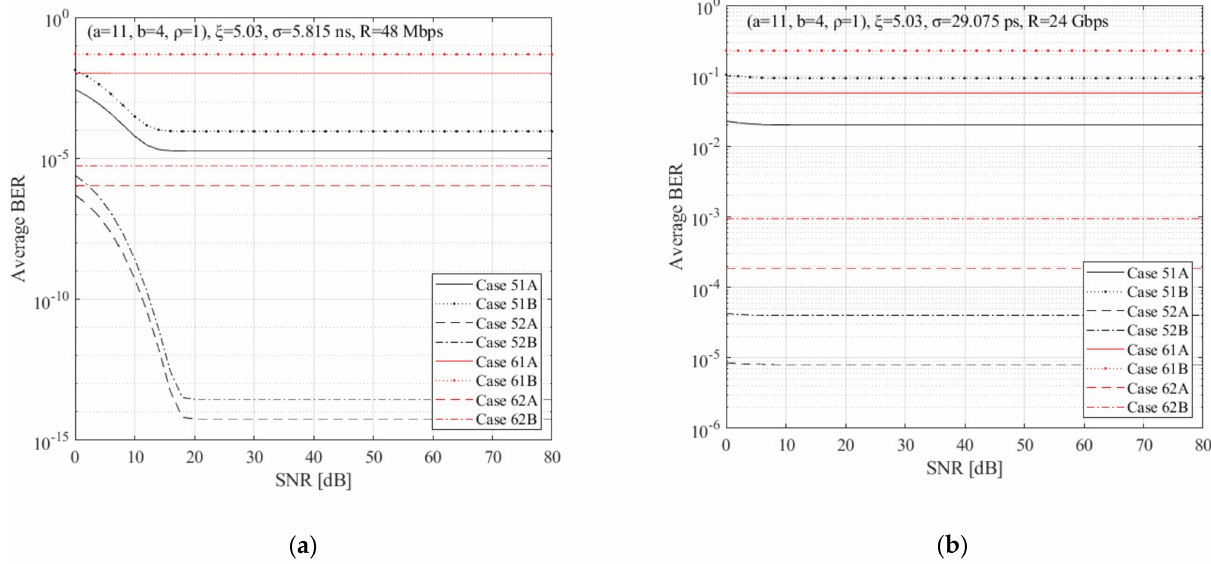
Figure 6. ABER versus expected SNR for ( a = 11, b = 4, ρ = 1), ξ = 5.03, L -PPM schemes, and various diversity and DF multi-hop parameters, with ( a ) R = 48 Mbps, σ = 5.815 × 10 − 9 s ( α = 10 − 8 s, β = 4) and ( b ) R = 24 Gbps, σ = 29.075 × 10 − 12 s ( α = 5 × 10 − 11 s, β = 4). The studied curve cases are codified as follows: Case 51A: 4-PPM, N = 3 , M = 1; Case 51B: 4-PPM , N = 3 , M = 5; Case 52A: 4-PPM , N = 9 , M = 1; Case 52B: 4-PPM , N = 9 , M = 5; Case 61A: 16-PPM , N = 3 , M = 1; Case 61B: 16-PPM , N = 3 , M = 5; Case 62A: 16-PPM , N = 9 , M = 1; Case 62B: 16-PPM , N = 9 , M =